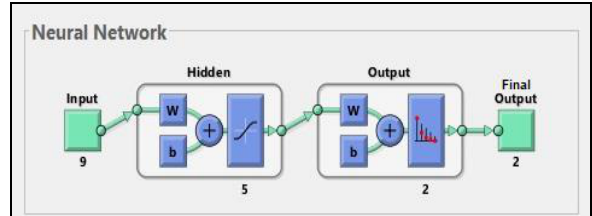
Figure 4. The structure of the neural network.